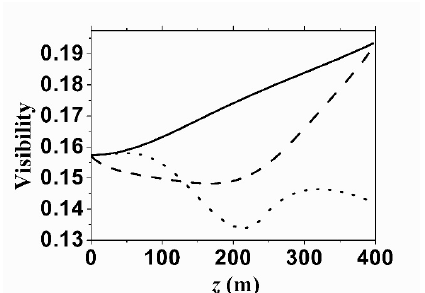
Figure 5. Visibility of lensless ghost image against the propagation distance. Solid line: free space; dashed line: monostatic turbulence; dotted line: bistatic turbulence.